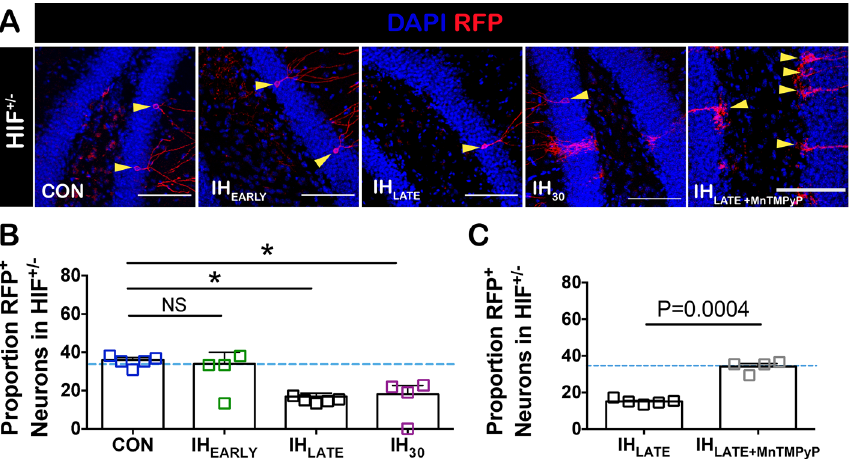
Figure 7. Stage-dependent differences in cell-autonomous HIF1a signaling among neural progenitors is revealed by HIF1a hemizygosity and antioxidant treatment. ( A ) Representative images from CON, IH EARLY , IH LATE , and IH 30 for RFP + labeled neurons derived from HIF1a +/− birth dated NSCs. Yellow triangles denote RFP + neurons. Scale bars are 100 μm. ( B ) While no difference between the proportion of RFP + neurons in CON and IH EARLY (CON: n = 5, IH EARLY : n = 4) was observed, differences were detected between CON and IH LATE (IH LATE : n = 5) and CON and IH 30 (IH 30 : n = 4). The percentage of RFP + neurons derived from HIF1a +/− NSCs (blue squares) was similar to that of neurons generated from birth dated WT NSCs (light blue dashed line, from Fig. 2 CON). * = P < 0.05; NS = P ≥ 0.05. one-way ANOVA with Dunnet’s multiple comparisons: P = 0.0015, F = 8.856. Con vs. IH EARLY : P > 0.05 (NS), CI of diff = − 7.101 to − 18.71. Con vs. IH LATE : P < 0.01, CI of diff = 8.067 to 32.40. Con vs.